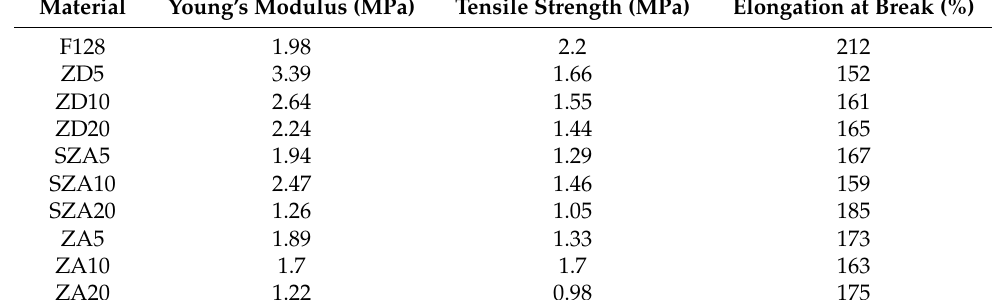
Figure 6. Tensile strength of the tested materials.